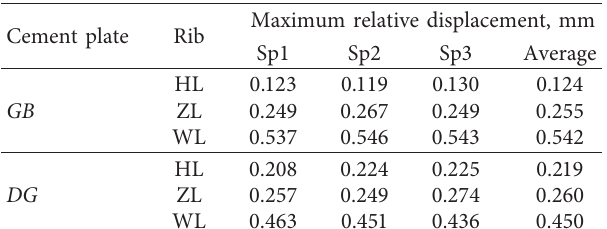
Table 10: Maximum relative bond-slip of the plate-concrete in- terfaces at failure for composite samples with different